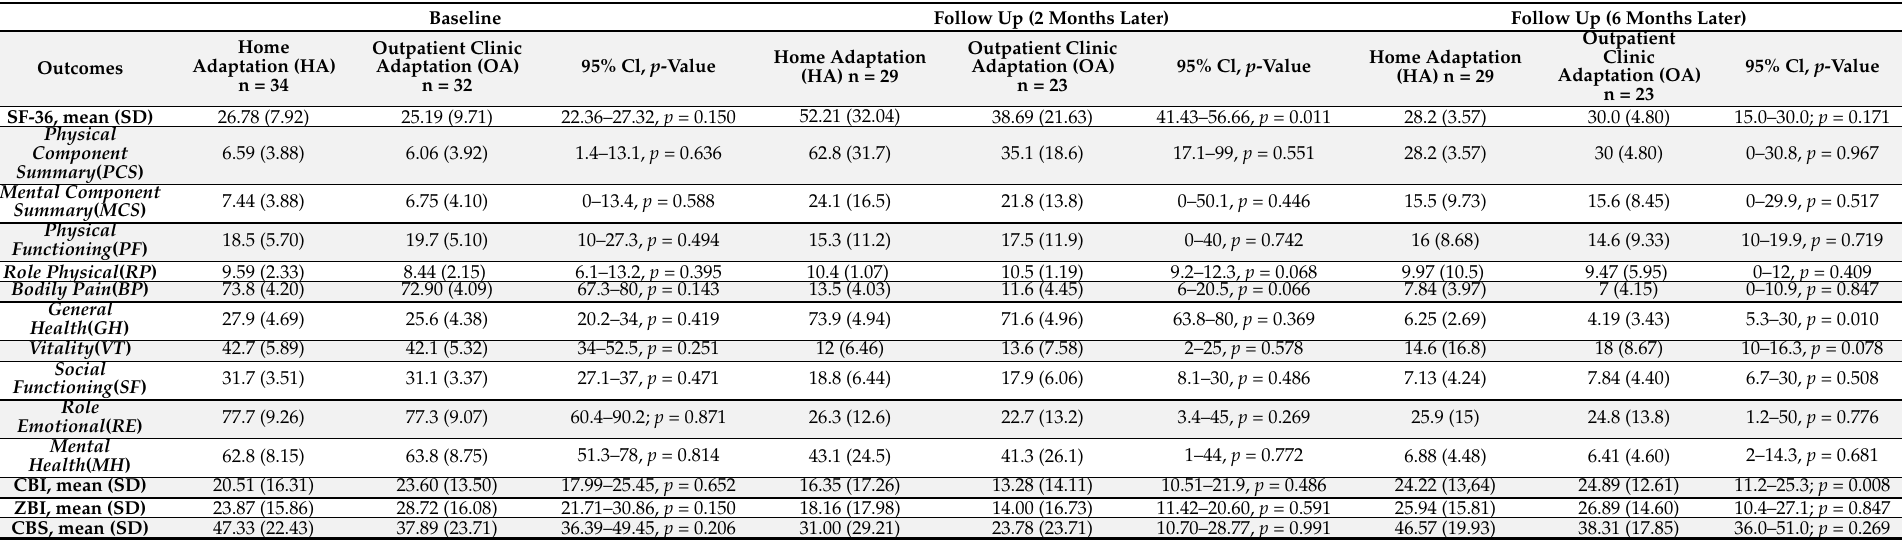
Table 3. Quality of life and caregiver burden result between